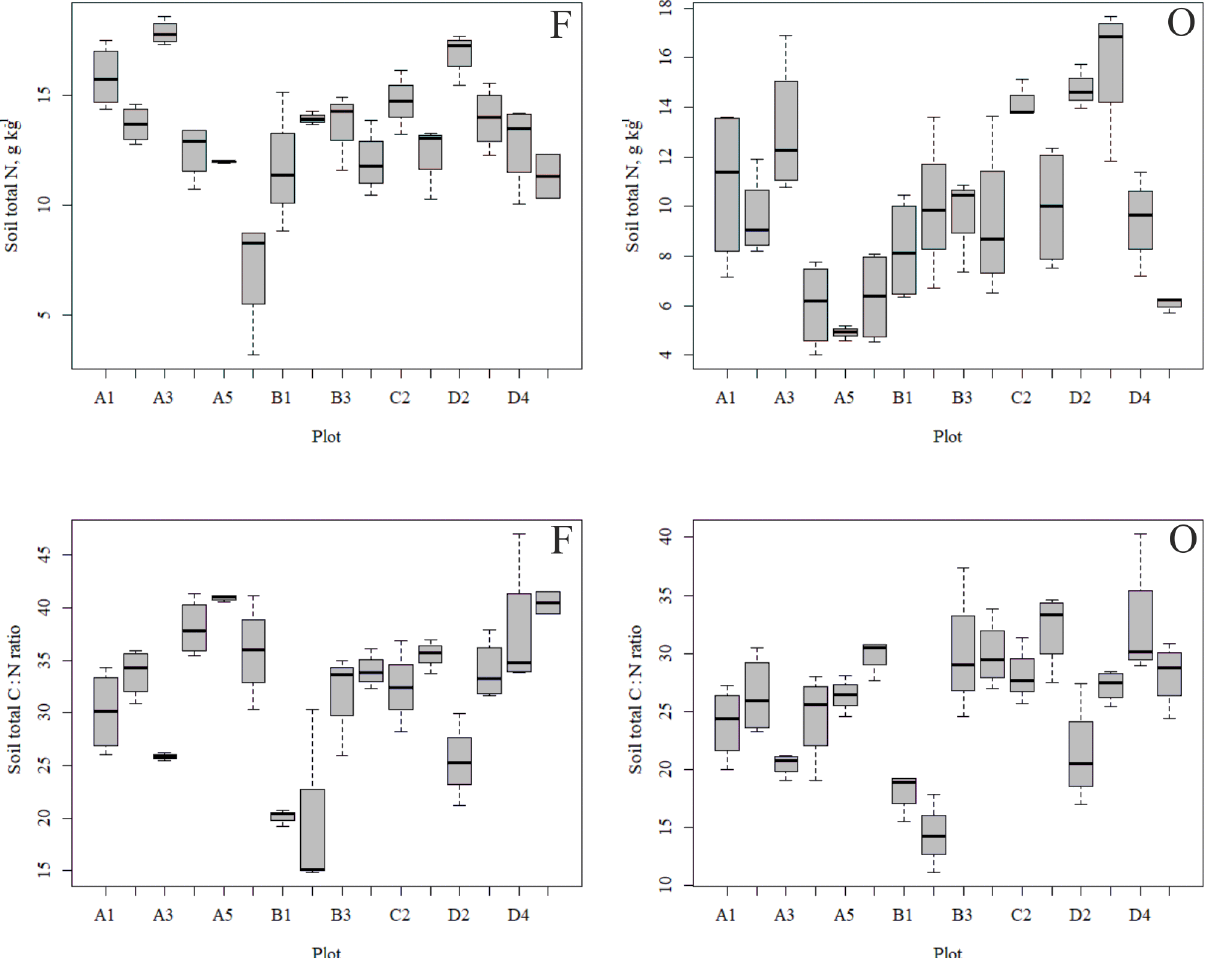
Figure C3. Soil total N content and C : N ratio within plots in the F and O